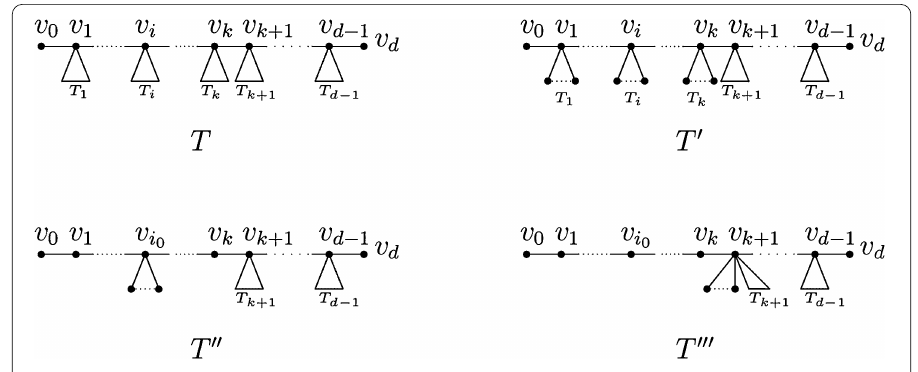
Figure 4 T , T (cid:2) , T (cid:2)(cid:2) and T (cid:2)(cid:2)(cid:2) .